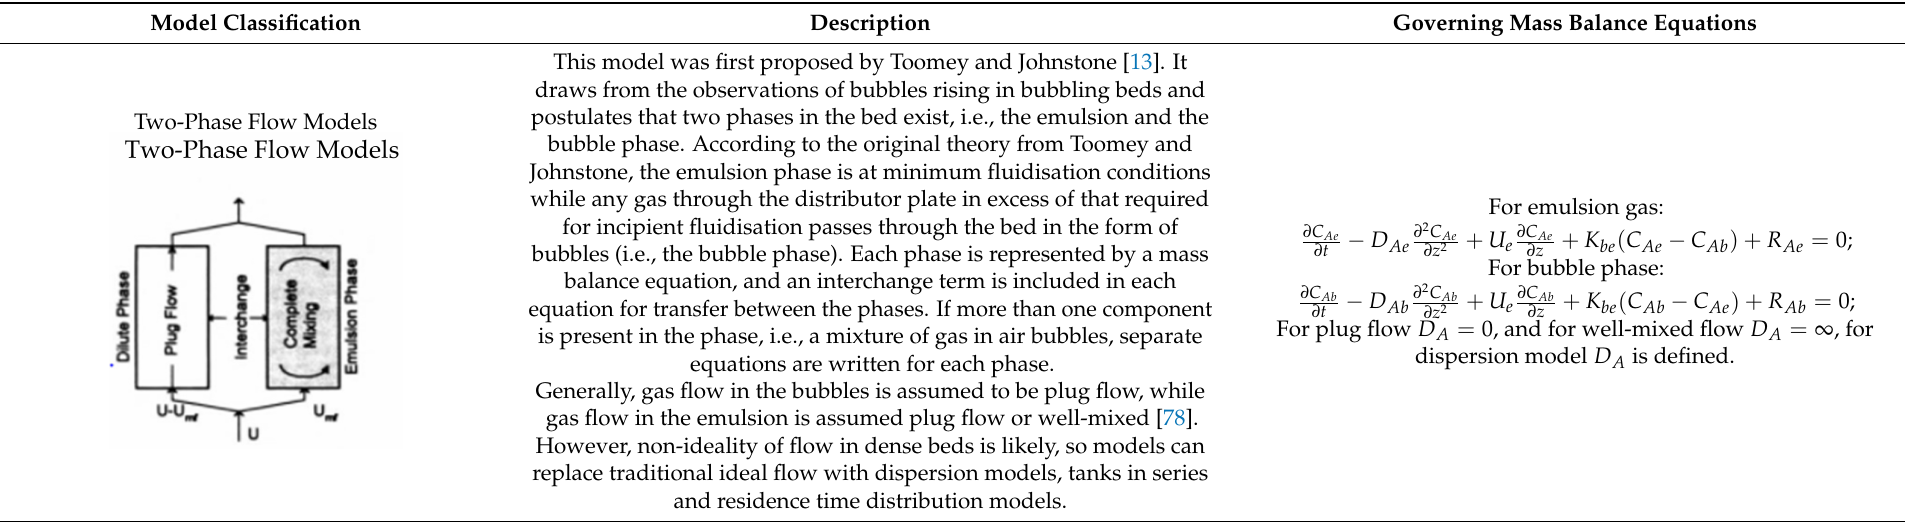
Table 3. Classification of reactor hydrodynamic models for FCC regenerator type Fluidised